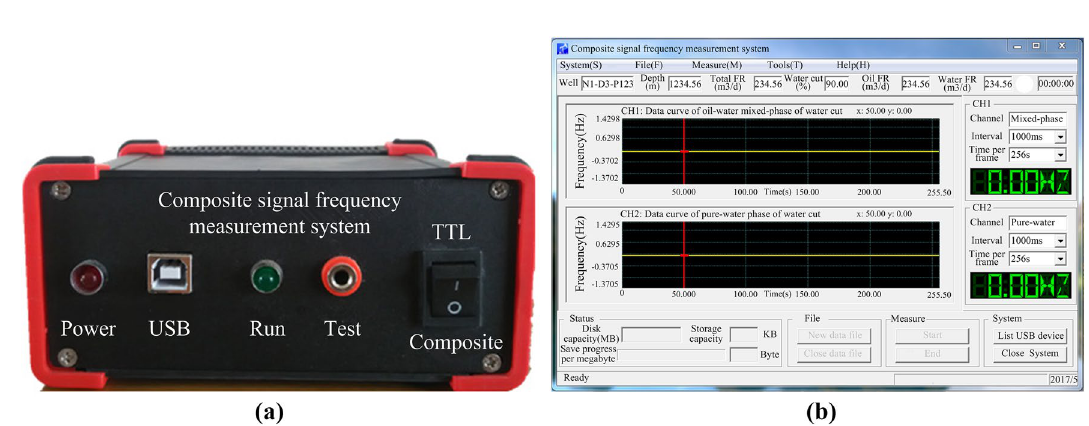
Fig. 11 Multi-channel signal frequency acquisition platform: a hardware of composite signal frequency measurement system, b software of composite signal frequency measurement